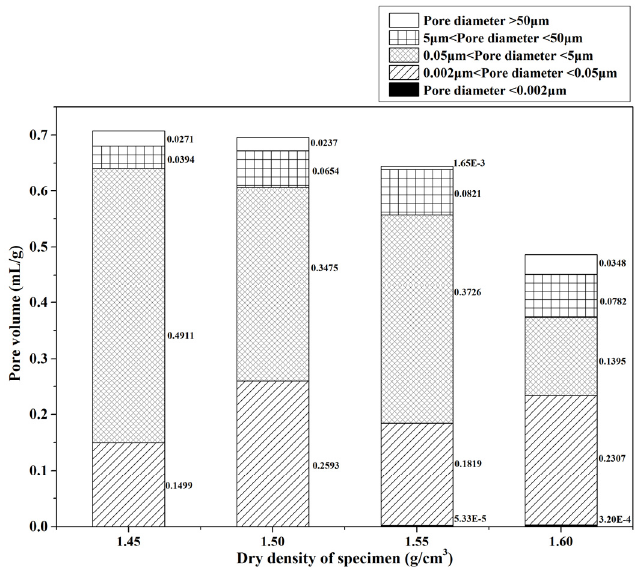
Figure 4. Pore volume distributions for samples with different dry densities.